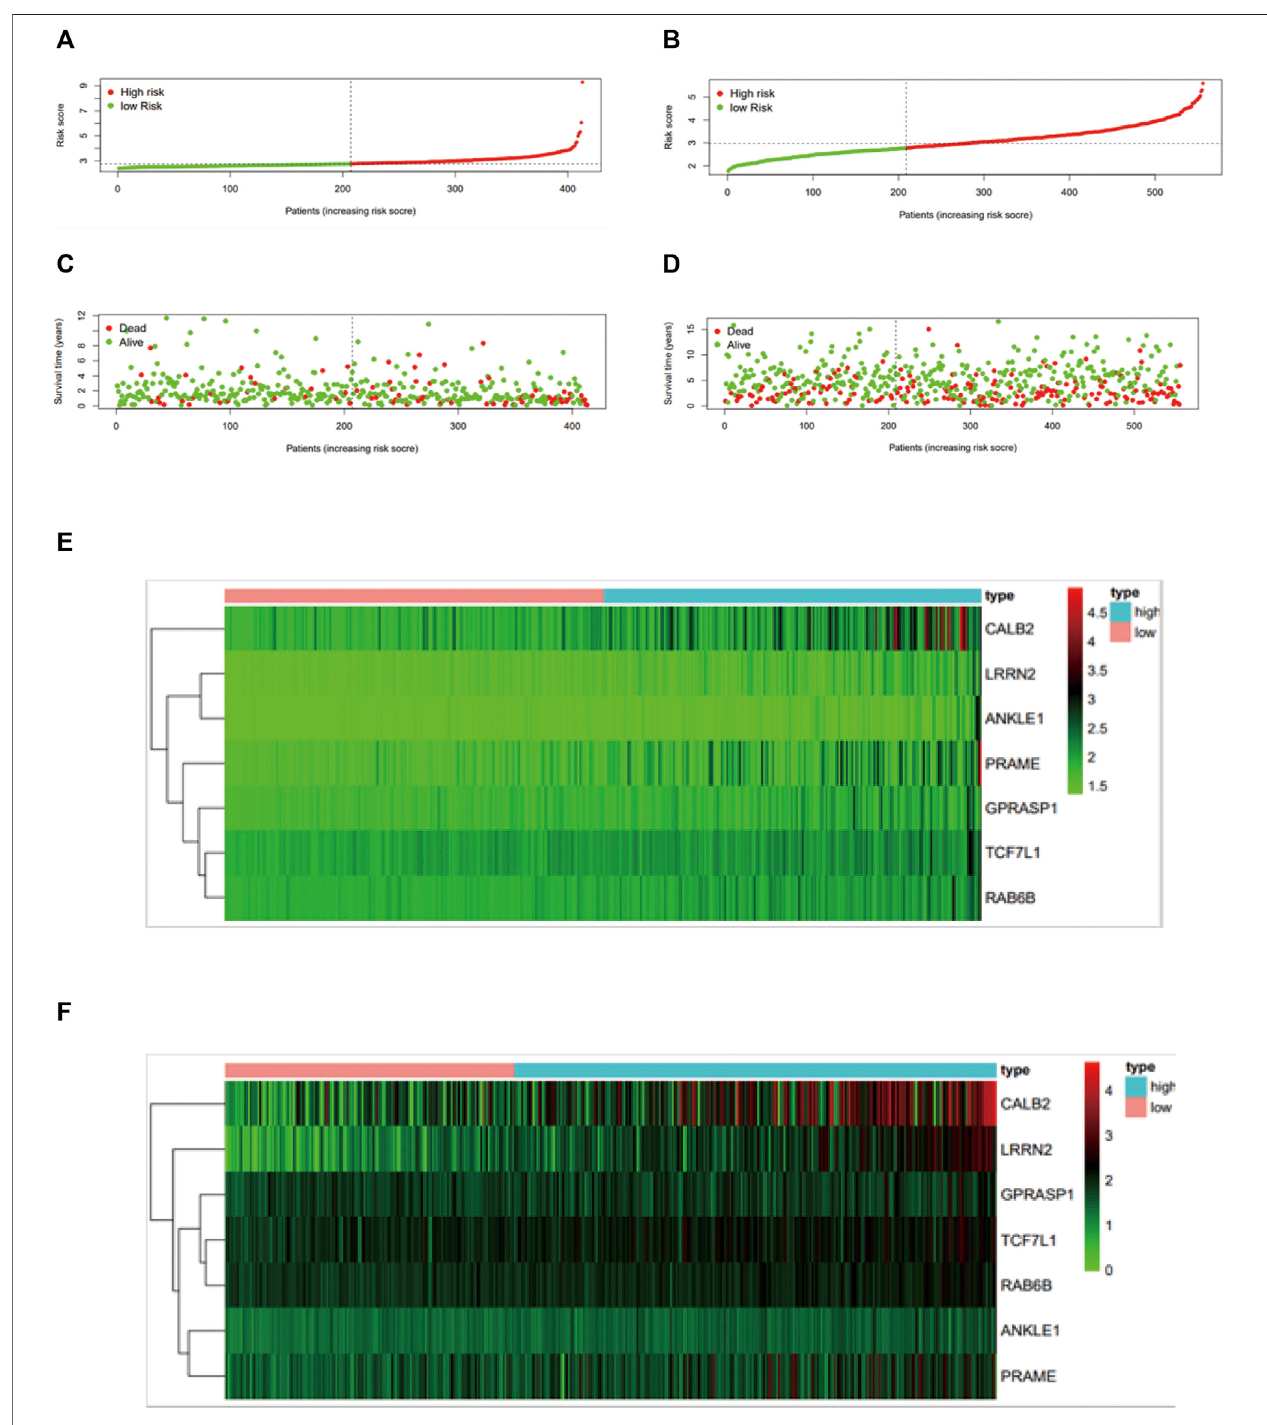
FIGURE 3 | Construction and validation of the mtDNA-related prognostic signature. Assessment of LASSO regression analysis of 475 DGEs is shown here. (A) Risk score, (C) survivalstatus,and (E) pro fi lesofmtDNA-associatedgeneexpression.ThevalueofthemtDNA-related prognosticsignaturewasvalidatedinGSE39582 by the (B) risk score, (D) survival status, and (F) mtDNA-related gene expression pro fi les, and GSE39582 was displayed in Figure 4 .